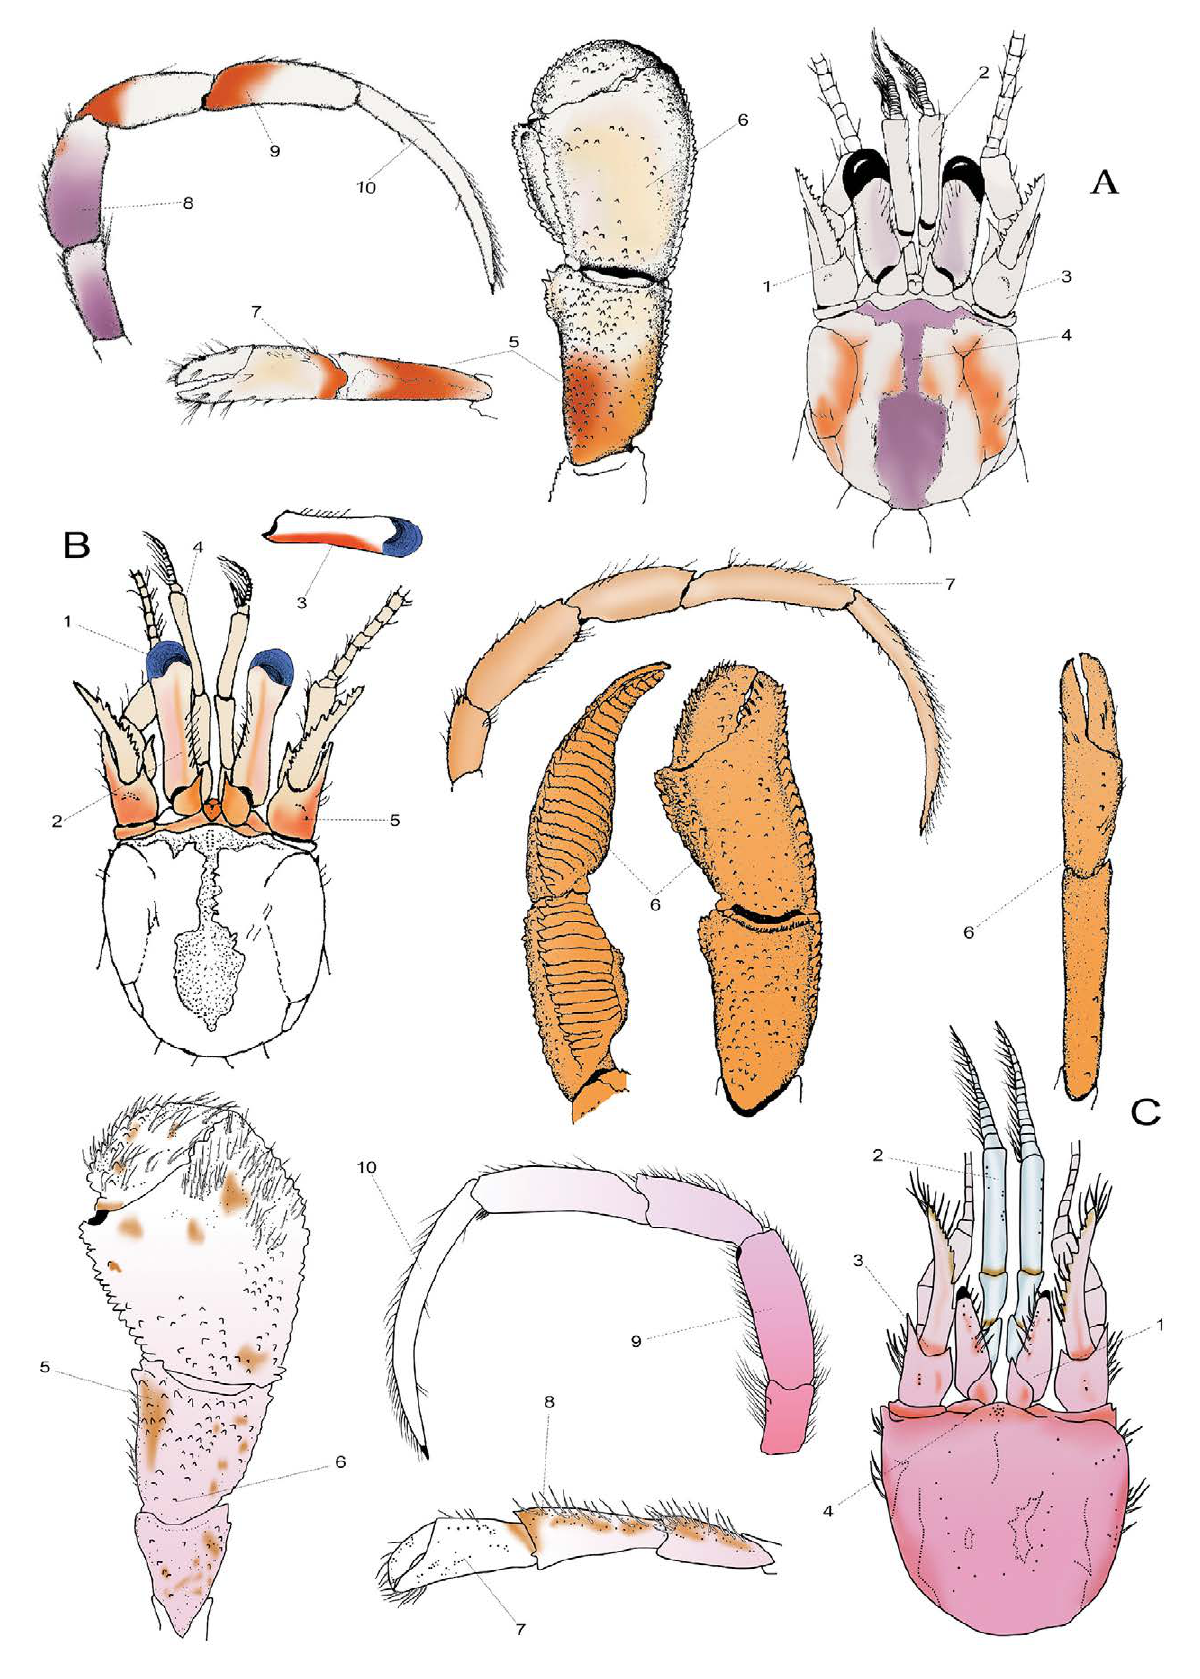
Fig. 14. – Colour patterns of Parapaguridae species: Oncopagurus bicristatus (A, 1-10); Paragiopagurus ruticheles (B, 1-7); Sympagurus acinops (C, 1-10). Vectorial drawings modified from A, Lemaitre (2014); B, Lemaitre (2013); C, present